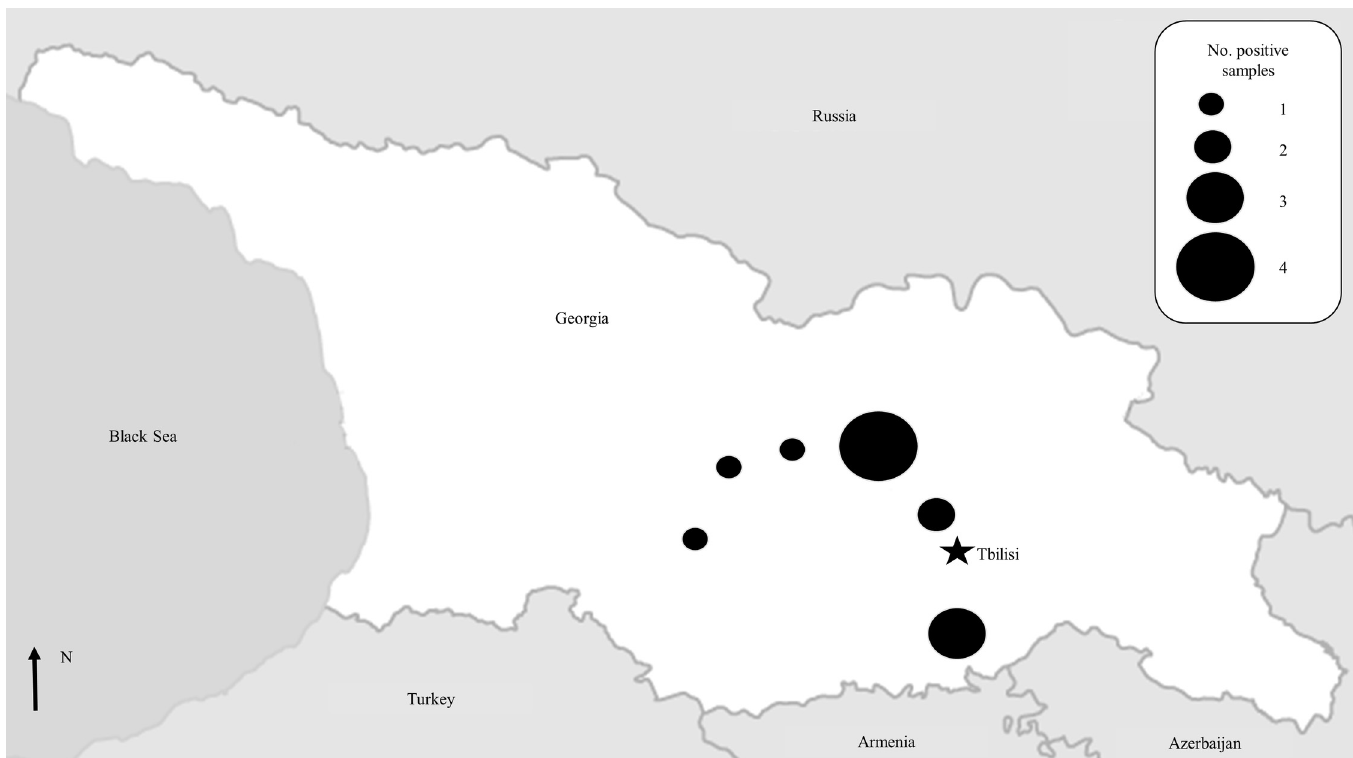
Fig 2. Geographic distribution of Crimean-Congo hemorrhagic fever (CCHF) seropositive participants among survey participants during an investigation of the 12 rural villages reporting at least one 2014 CCHF case from January to September 2014 in Georgia. Georgia is demarcated in white with surrounding countries in gray. The capital, Tbilisi, is indicated by a star. Circle size indicates the number of seropositive subjects in that area; the bigger the circle, the higher the number of seropositive subjects. Map adapted from MapsOpenSource.com.